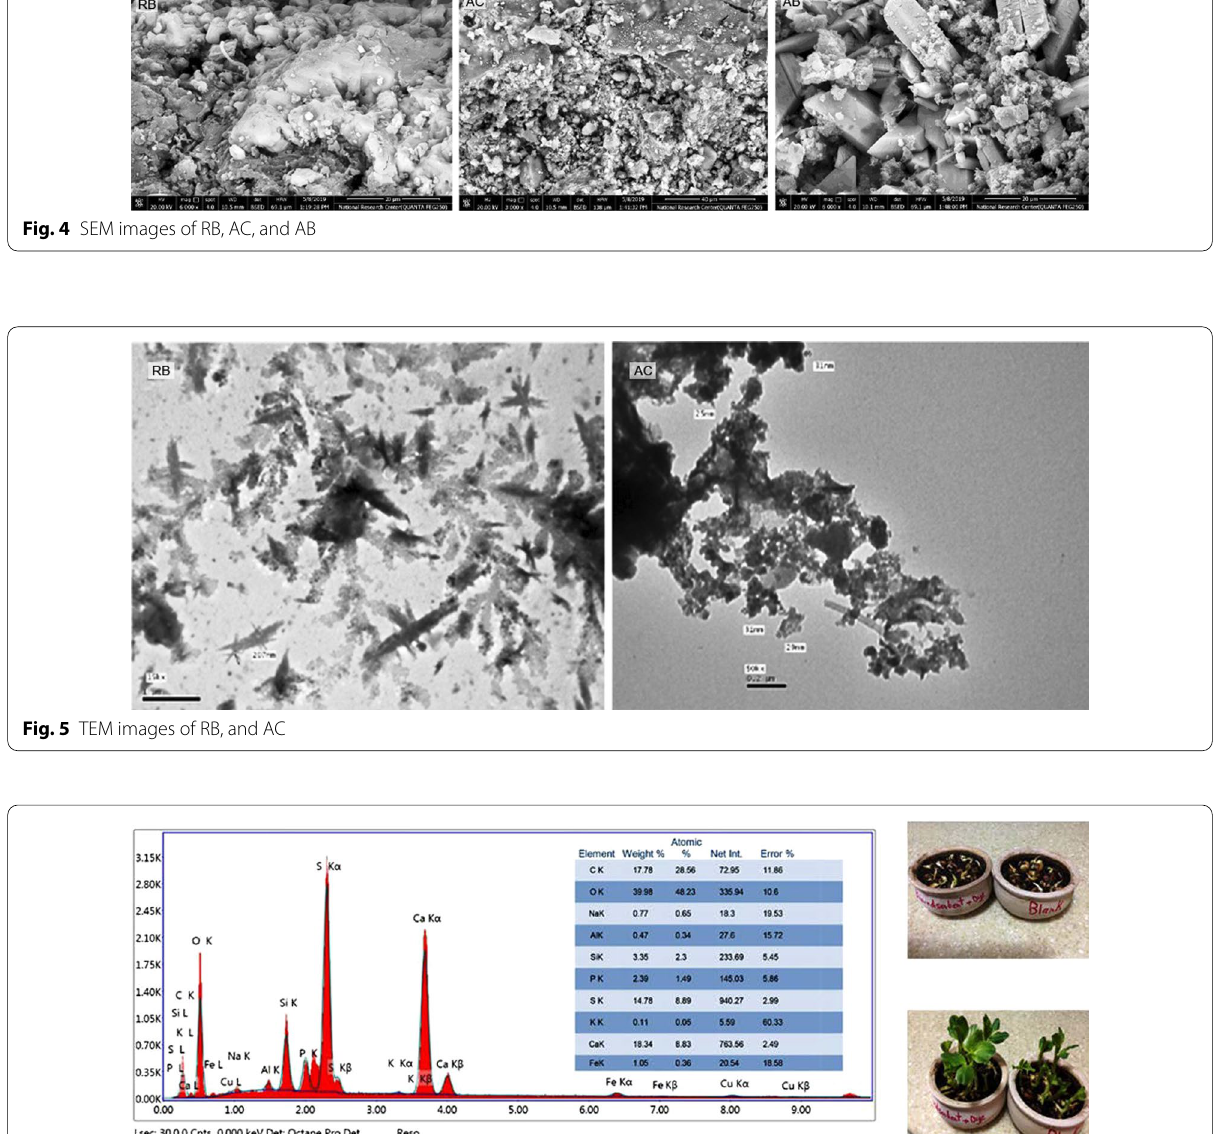
Fig. 6 Elemental analysis for AB using EDX and its reflection on